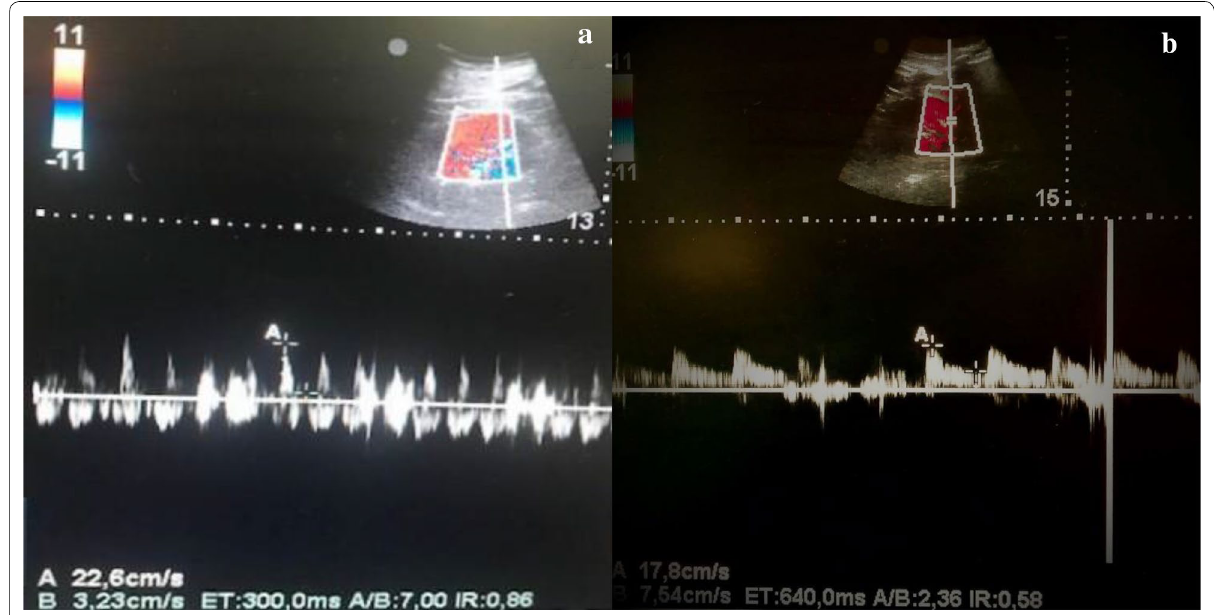
Fig. 1 Renal Resistive Index. Pre- ( a ) and post- ( b ) surgical intervention of